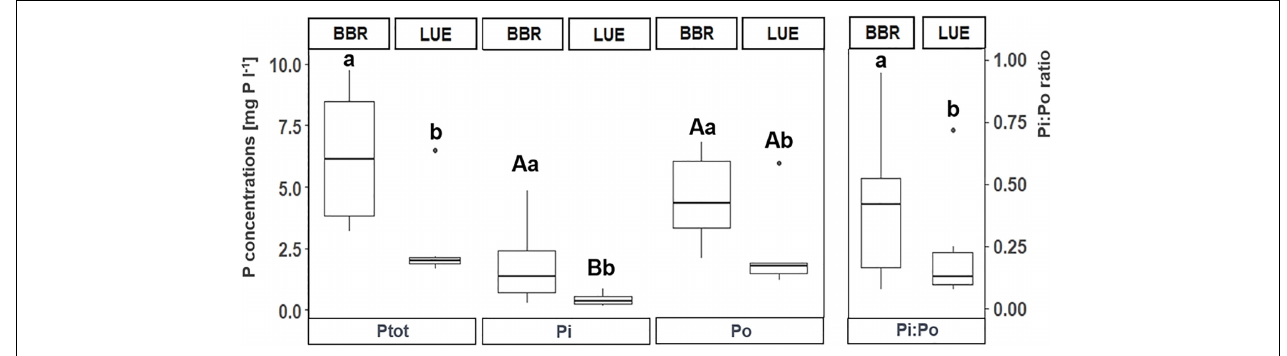
FIGURE 2 | Total (Ptot), inorganic (Pi) and organic (Po) phosphorus concentrations (mg P l - 1 ), and Pi:Po ratios in xylem sap of trees in the control plots. Note that Pi:Po ratios refer to the second y -axis. For ease of reading, samples were pooled from both sampling periods but treated separately for statistical analyses. Lowercase letters indicate differences between sites whereas uppercase letters indicate significant differences between Pi and Po concentrations of a given site. BBR = Bad Brückenau; LUE = Lüss.